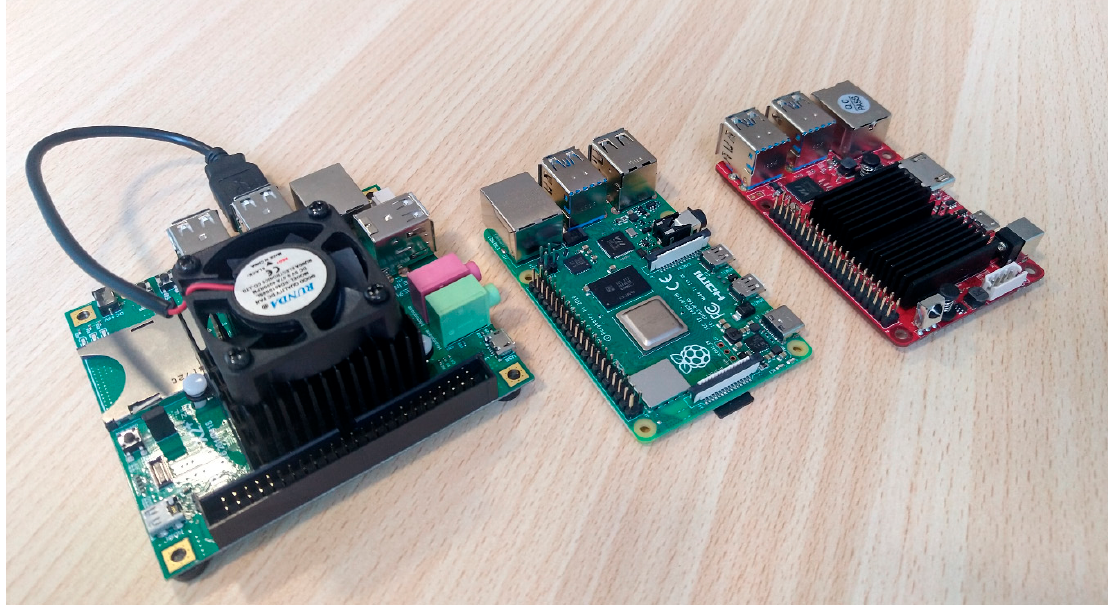
Figure 4. The ARM-based platforms used in the tests, from the left: ODROID-X2, Raspberry Pi 4, ODROID-C4.